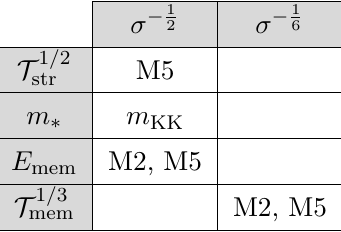
Table 8 . Mass scalings along the flow generated by an elementary string obtained from a wrapping